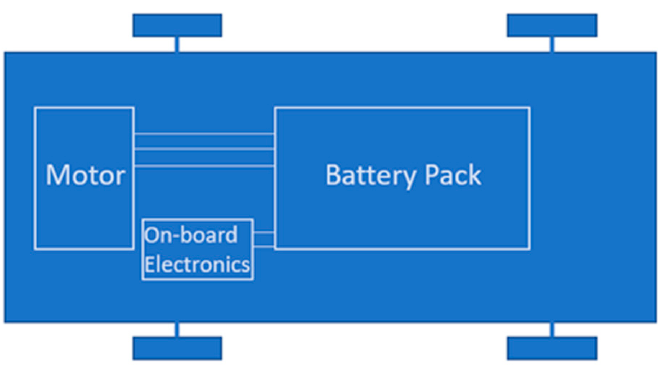
Figure 9 displays the basic layout of an electric drivetrain for an EV, highlighting the electric motor located under the van’s bonnet, often known as the ‘engine bay’ area in ICE vehicles. The motor is able to provide instant torque, as well as being very quiet and requiring lower maintenance than an ICE vehicle [89]. The battery pack is located under the chassis of the vehicle between the front and rear axles, which connect the front and rear wheels, respectively. Fitting it under the chassis, therefore, ensures that the load area in the rear of the vehicle is not decreased. Power electronics are utilised to connect the high-voltage battery to the electric motor and to the onboard electronics, supplying both with energy [89]. Regenerative braking may also be included to recover energy that is commonly lost during braking, by switching the motor to a generator operation and passing the current to the battery, to be stored for future use [89].